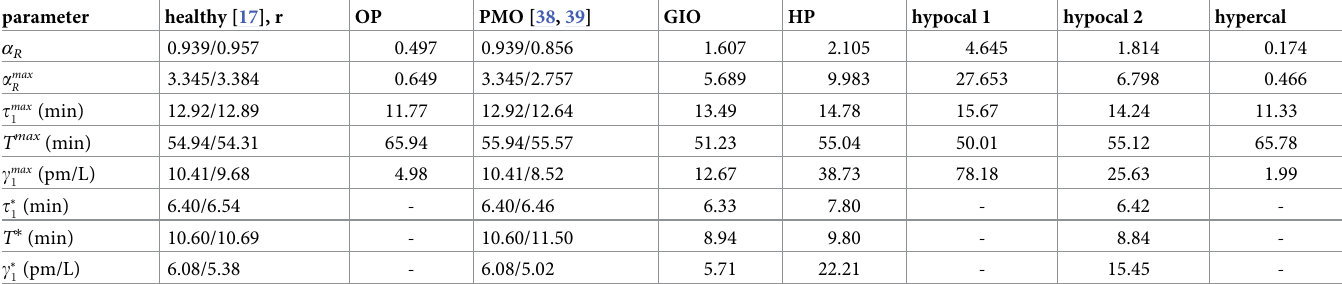
Table 3. Cellular responsiveness for gland secretion.